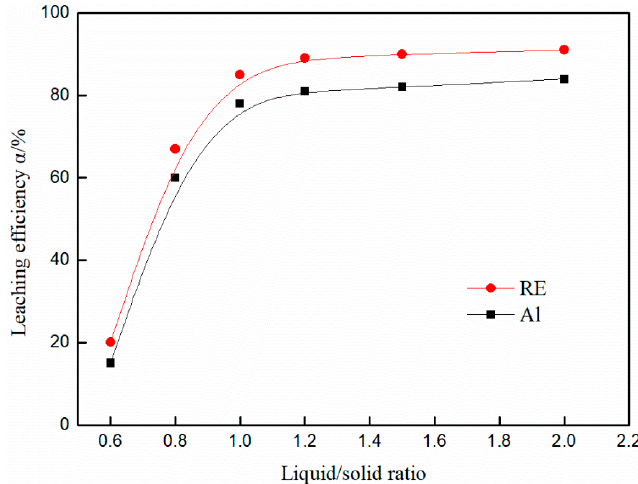
Figure 7. The effect of liquid/solid ratio on the leaching efficiency of RE and Al (250 g ore; C Mg2+ = 0.2 mol/L; flow rate = 0.5 mL/L; pH = 5.6; room